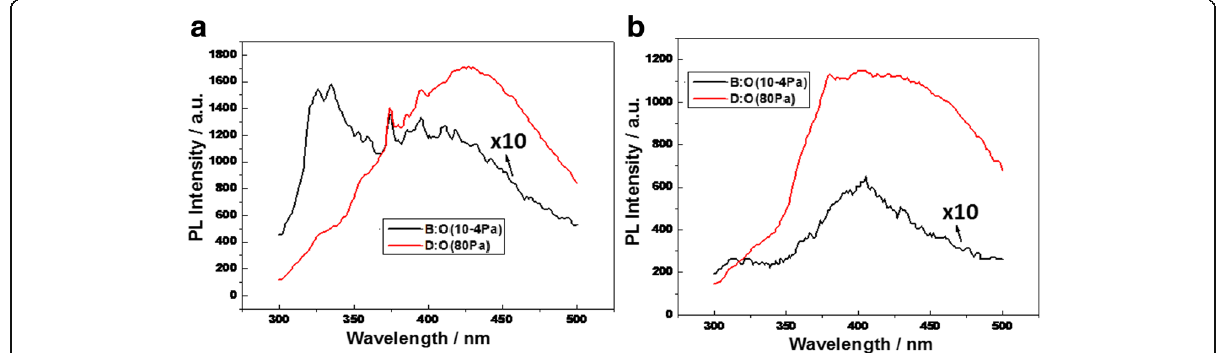
Fig. 2 a PL spectra from 300 to 500 nm measured at lower temperature on the sample I ( black curve ) and the sample II ( red curve ). b PL spectra measured at room temperature on the sample I ( black curve ) and the sample II ( red curve ), in which the impurity states on nanocrystals are exhibited in the broader enhanced PL peaks on the sample